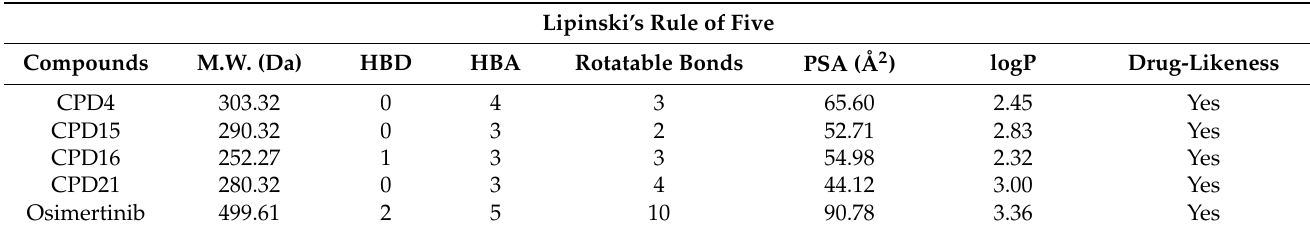
Table 1. Predicted Lipinski’s rule of five for the quinoxalinone-based compounds and osimertinib. (HBD, hydrogen bond donor; HBA, hydrogen bond accepter; PSA, polar surface area).